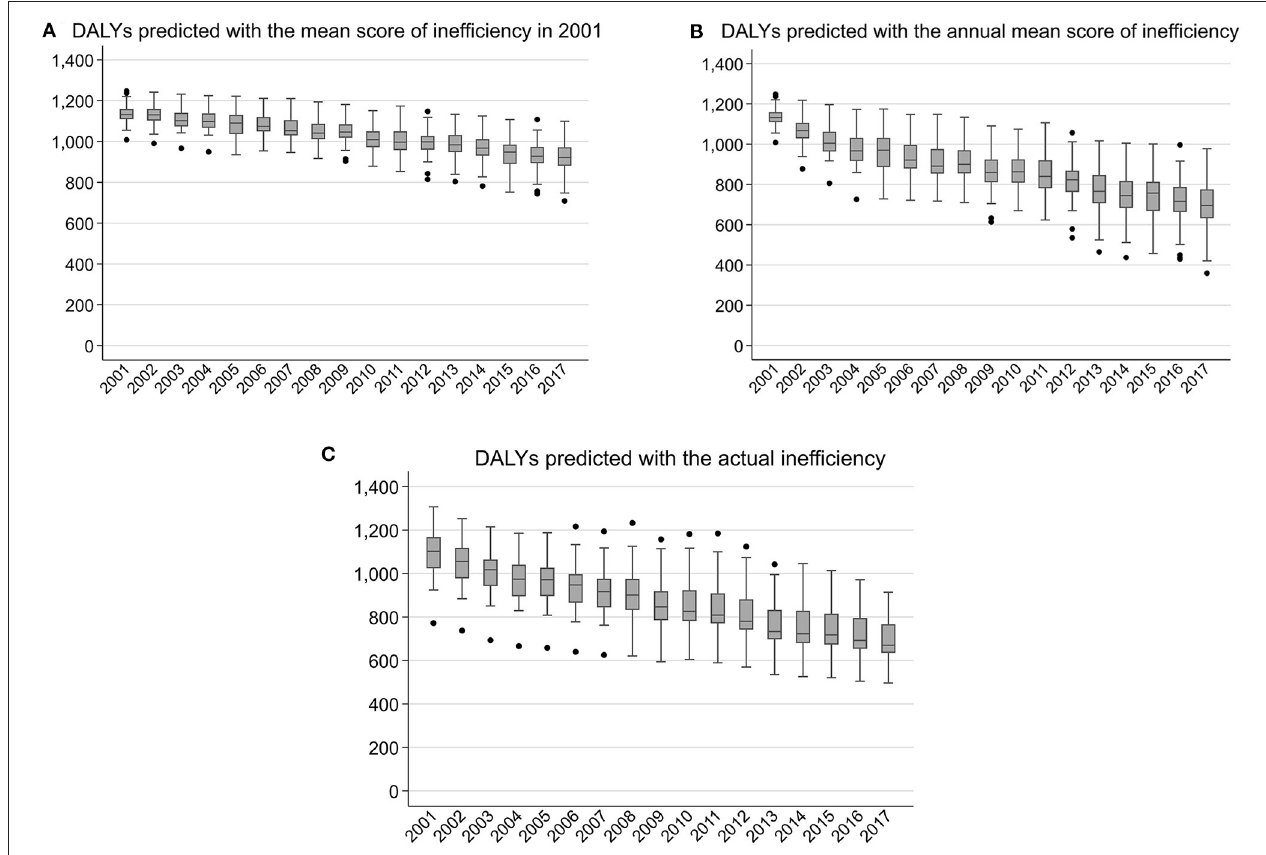
FIGURE 3 | Predicted DALYs from 2001 to 2017 based on the translog production function. DALYs, disability-adjusted life years. DALYs per 100,000 population aged under 5